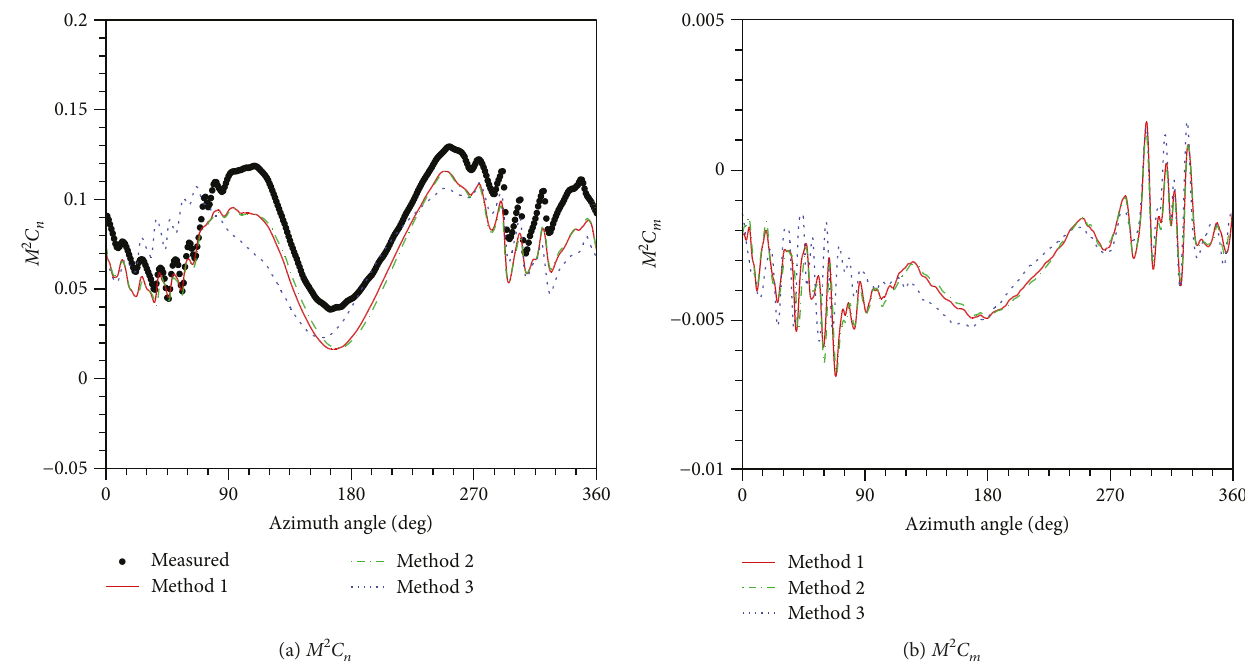
Figure 9: Comparison of section airloads at 87% radial